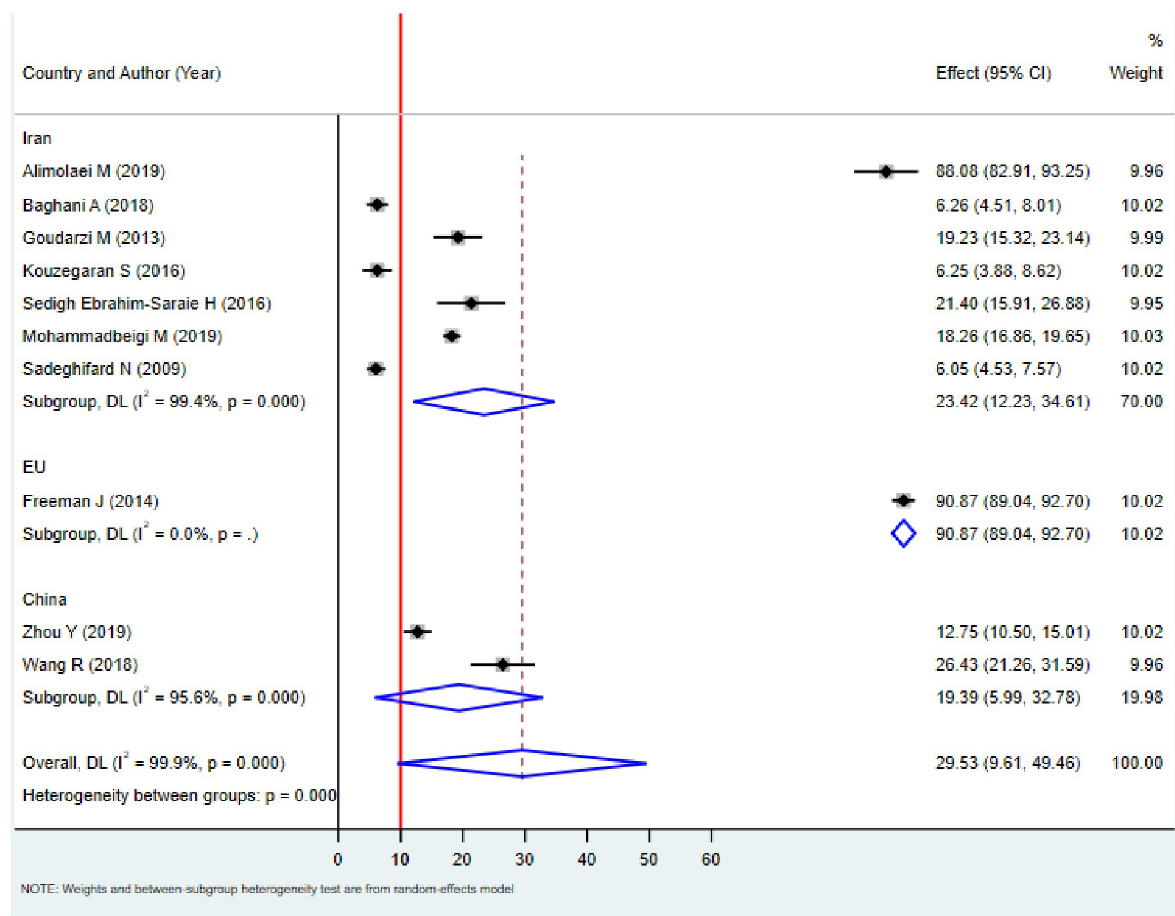
Fig 4. Forest plots for the proportion of C . difficile by country among hospitalized diarrheal patients.